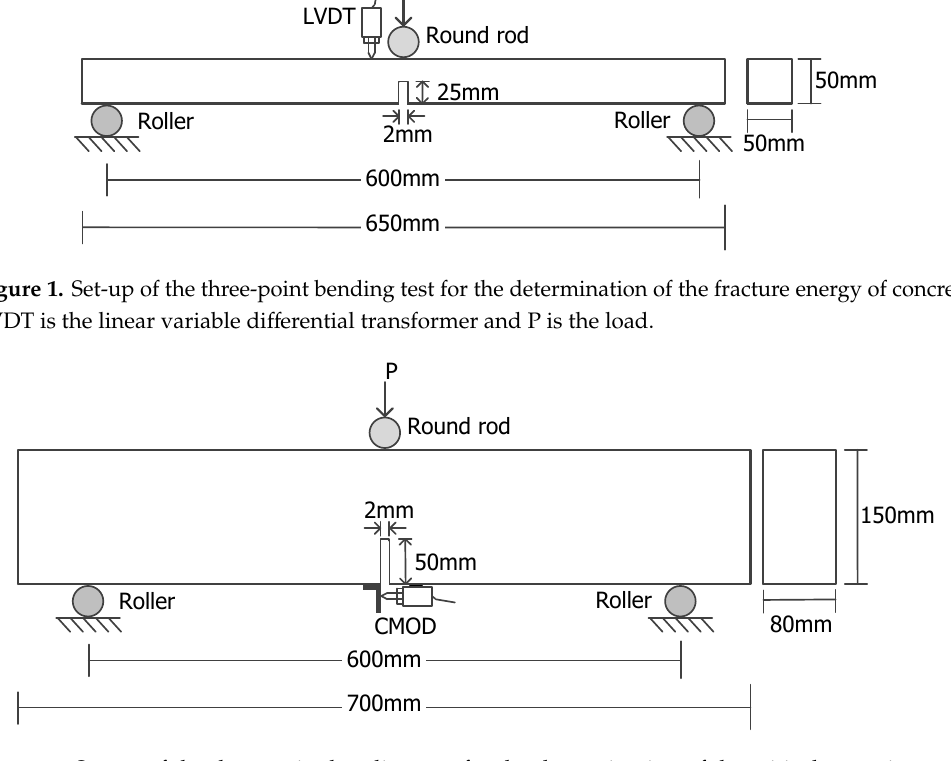
Figure 2. Set-up of the three-point bending test for the determination of the critical stress intensity factor of concrete. CMOD is the crack mouth opening